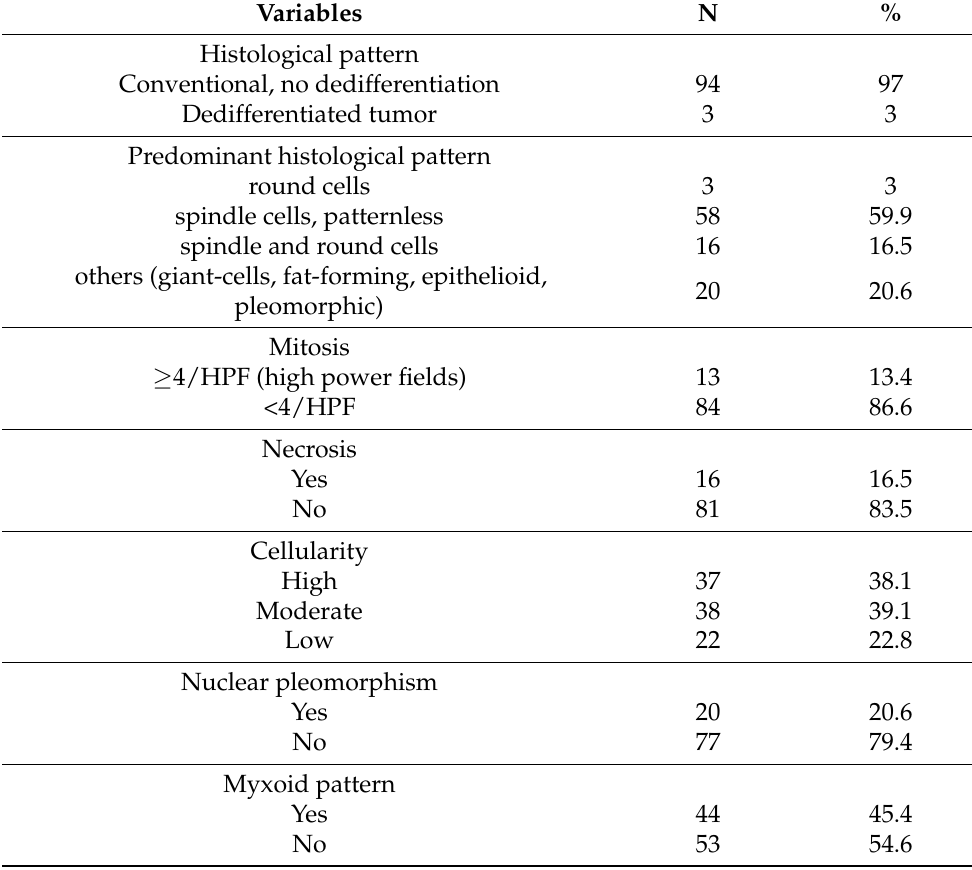
Table 3. Solitary fibrous tumor. Histological findings clinical (N =